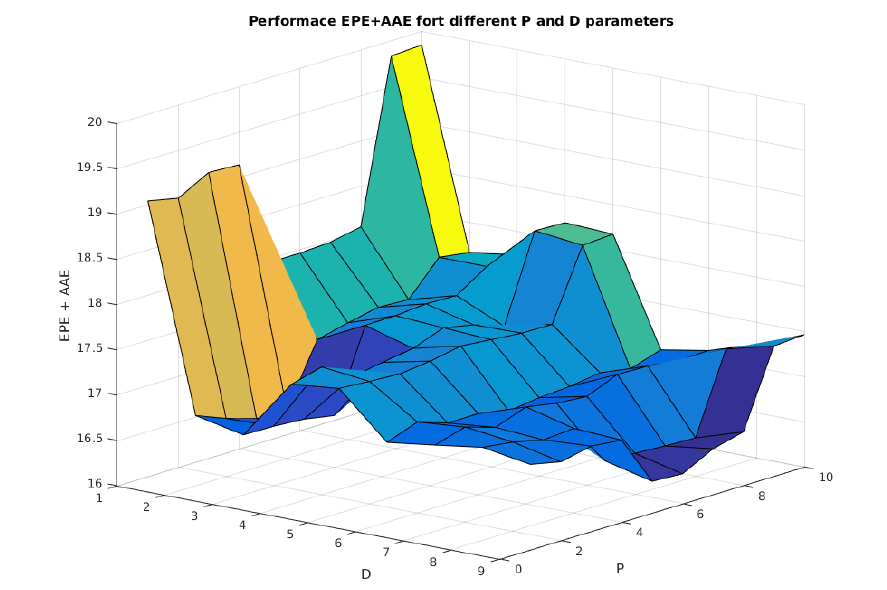
Figure 15. Performance of the proposed model considering variation in P and D